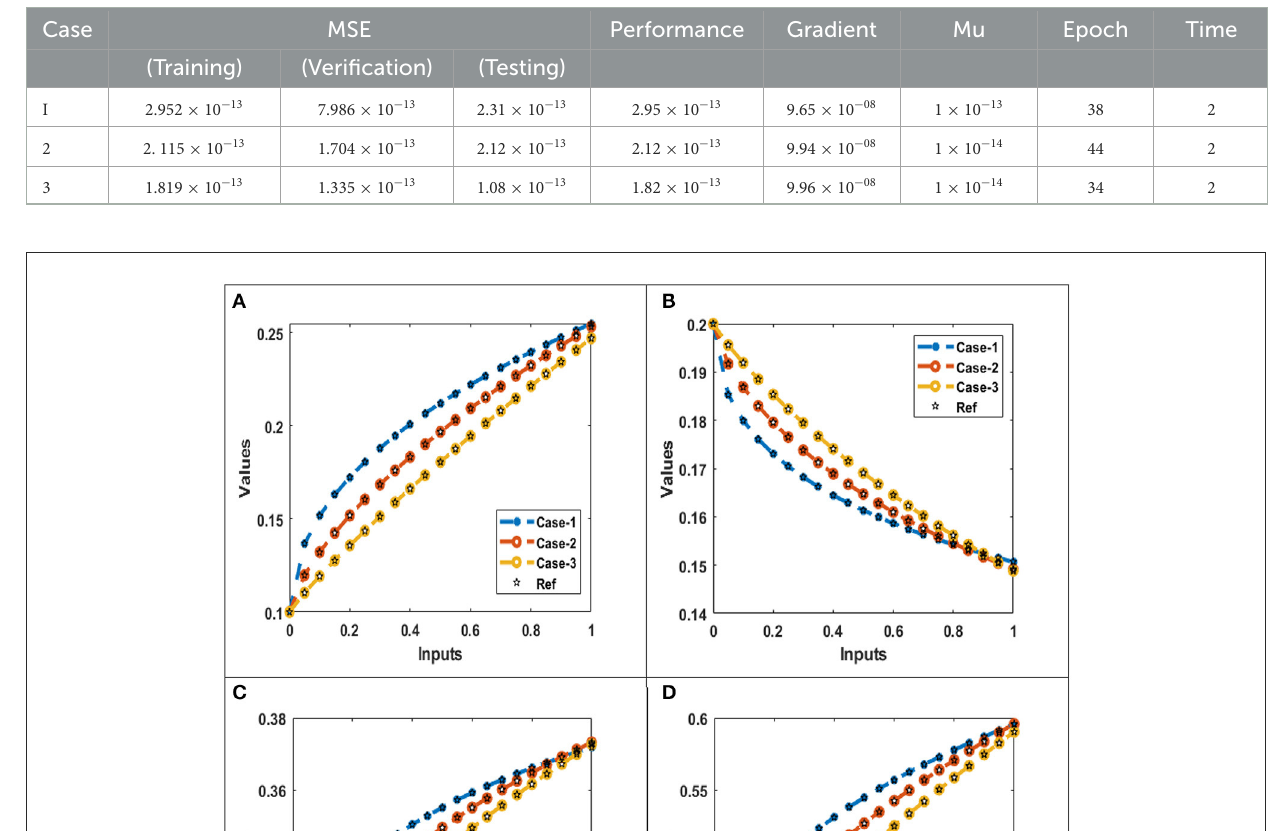
model for all three cases. Figure 11B describe AE value for symptomatic infections Y ( t ) is provided as 10 − 05 to 10 − 06 to solve the mathematical model for three cases. Figure 11C illustrate